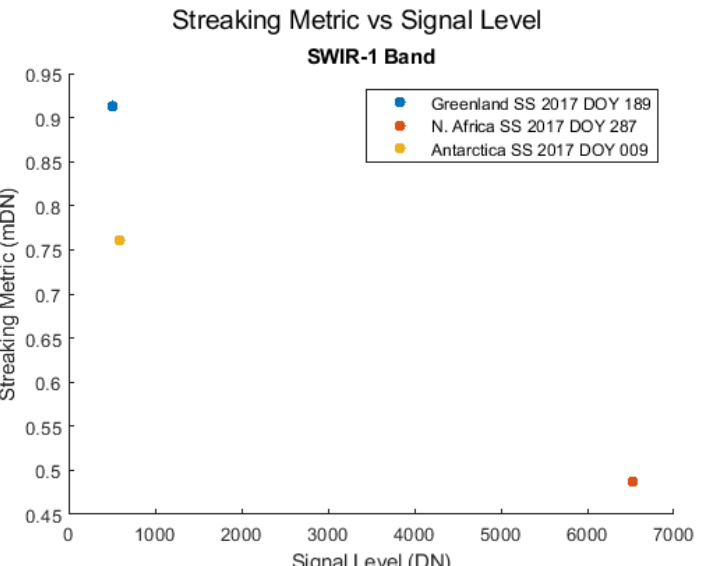
Figure 11. North Africa side-slither relative gains for the C/A band applied to FPM 2 of a Greenland scene ( left ); Greenland side-slither relative gains for the C/A band applied to FPM 2 of a Greenland scene ( right ). These two images have an identical contrast stretch applied to them for visualization purposes. Note the large amount of vertical stripes visible in the left image vs the right image.